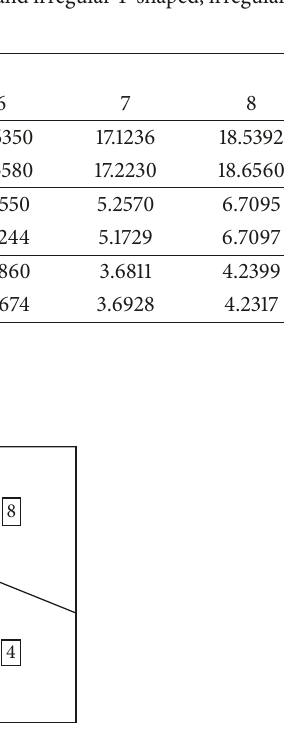
Figure 10: A rectangular thin plate divided uniformly into 8 right trapezoid elements and the serial numbers of each element and side.